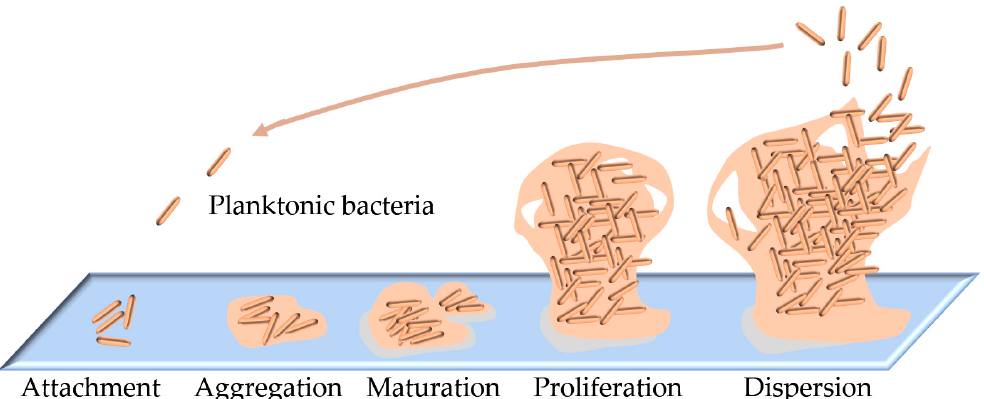
Figure 1. The life cycle of biofilms beginning with the initial cell attachment and ending with biofilm dispersal.